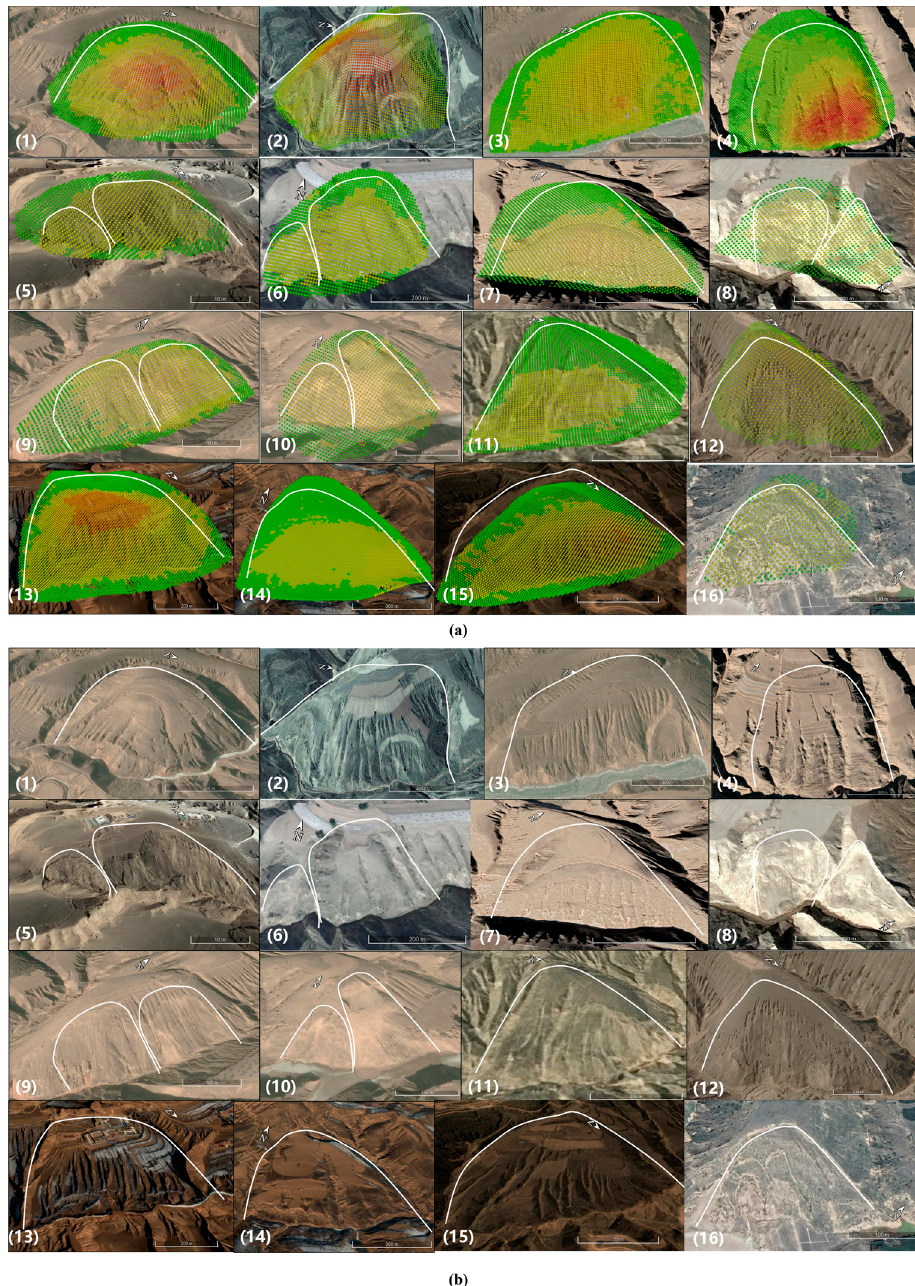
Figure 8. Typical loess landslides shown in deformation maps and optimal remote sensing images. ( a ) Enlarged deformation rate maps and ( b ) optical remote sensing images of 16 exemplary landslides. The white lines indicate the boundaries of the detected landslides. The optical-remote- sensing images were the perspectives of a Google Earth image.